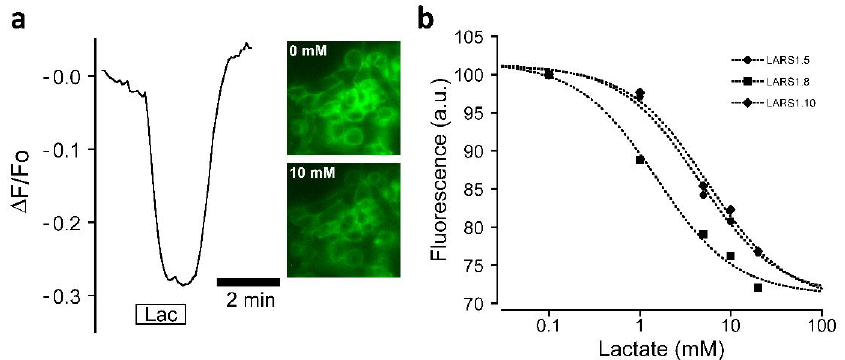
Figure 5. Responses of candidate biosensors to lactate application. ( a ) Representative fluorescent curve of LARS1.8 response to 10 mM lactate application. Widefield fluorescence images of recorded a group of HEK293 cells before and during application of lactate are shown (λ ex = 490 nm). ( b ) Lactate concentration dependence of LARS1.5, LAR1.8, and LARS1.10 fluorescence responses. Data points are mean values measured 6–7 groups of cells for each construct. EC 50 values were obtained by nonlinear curve fitting using the Levenberg–Marquardt algorithm. Data are normalized to the fluorescence measured in the absence of lactate.